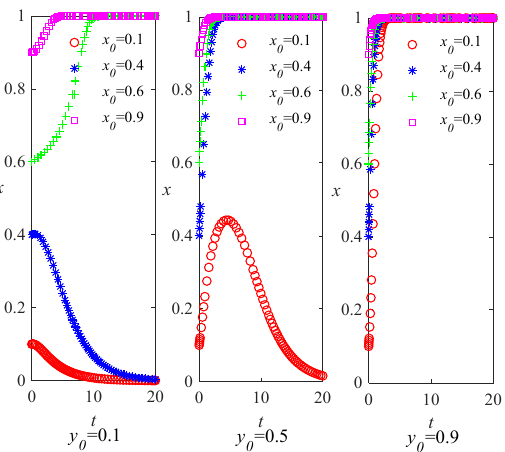
Figure 9. The impact of the initial policy ratio on system evolution results.